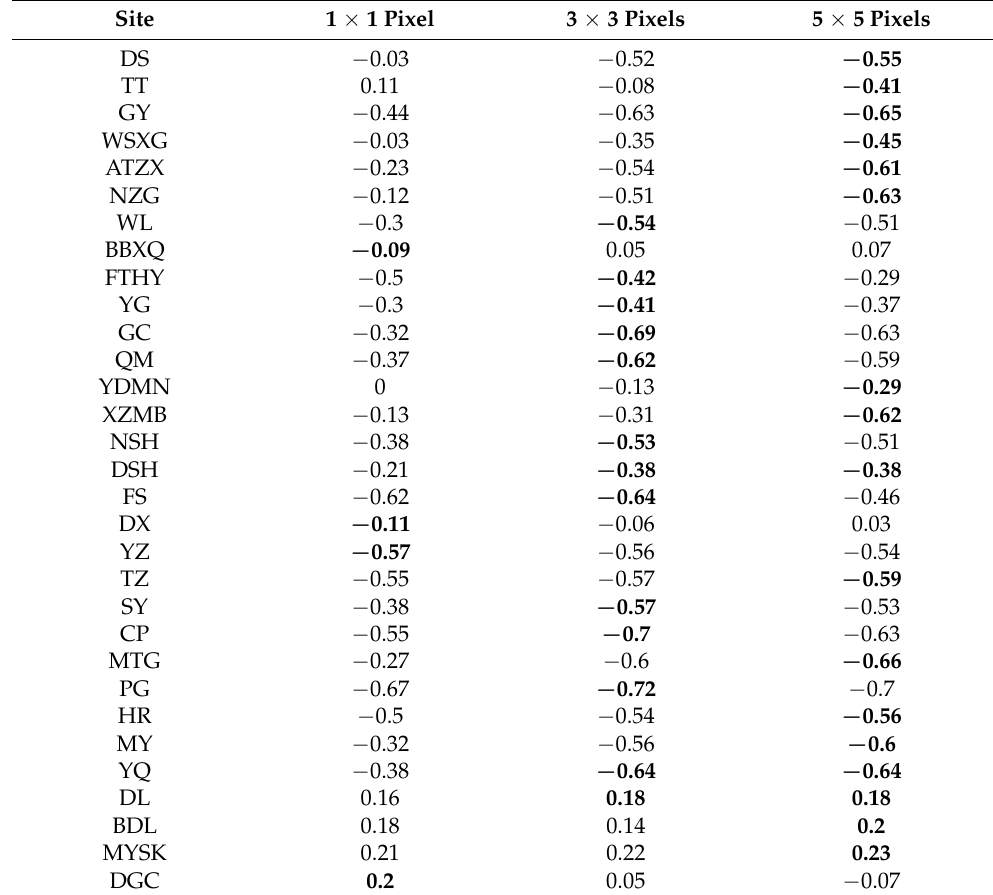
Table 2. Correlation coefficients between PM 2.5 / µ and ln(I) at different pixel scales for 34 ground monitoring sites: ln(I) is the natural logarithm of radiance extracted from DNB.